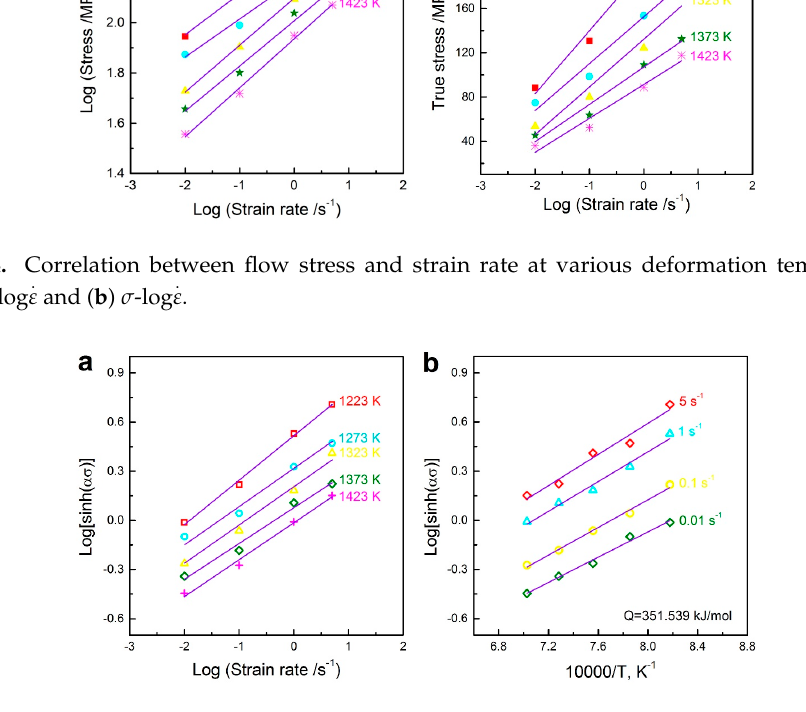
. ε at different temperatures and ( b ) log[sinh( ασ )]